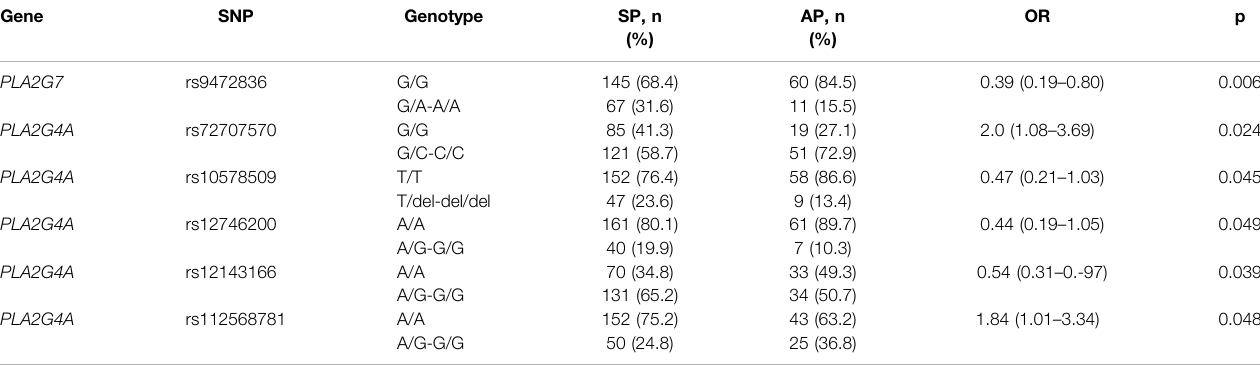
TABLE 3 | Adjusted association analysis with the risk of accelerated ccIMT progression in nephrosclerosis patients.